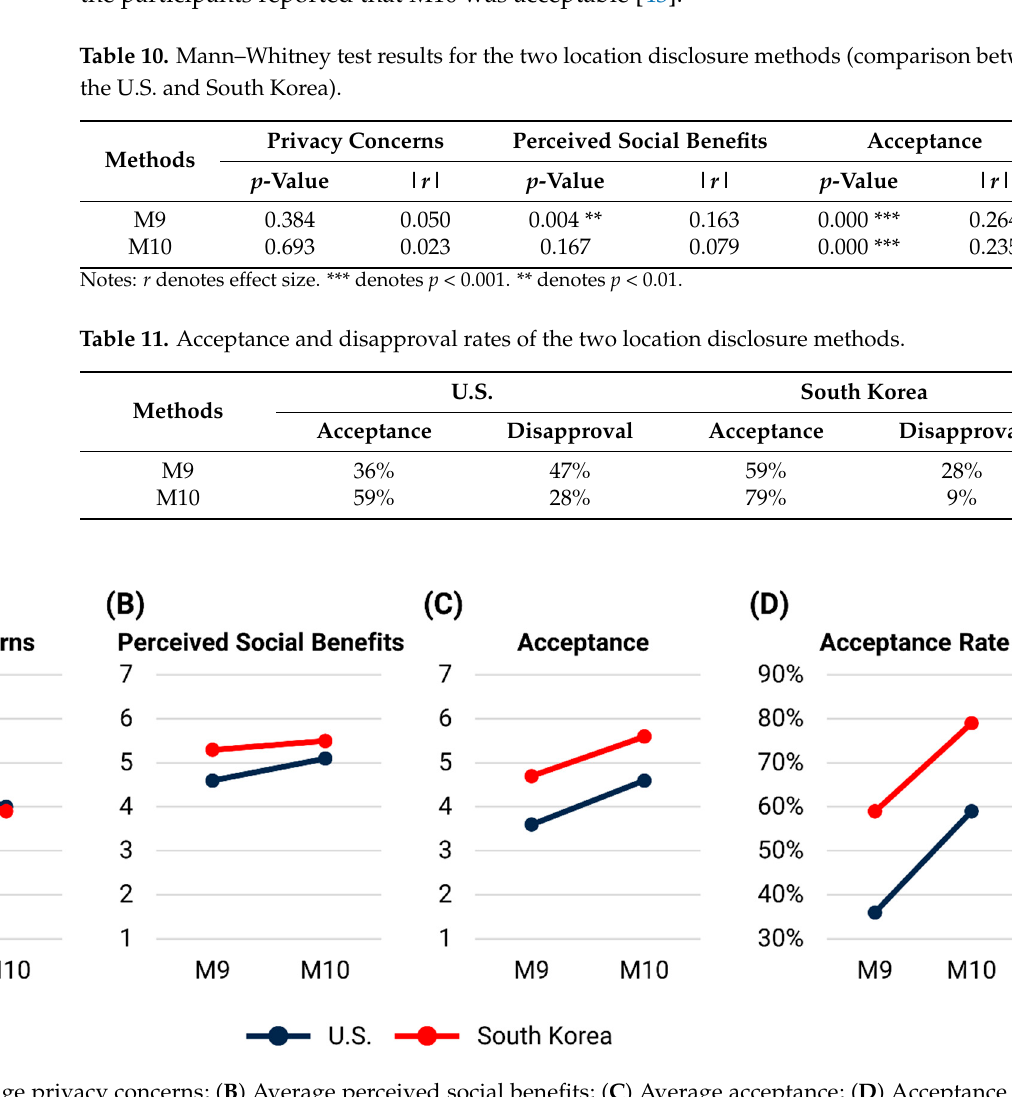
Figure 6. ( A ) Average privacy concerns; ( B ) Average perceived social benefits; ( C ) Average acceptance; ( D ) Acceptance rate (M9–10).